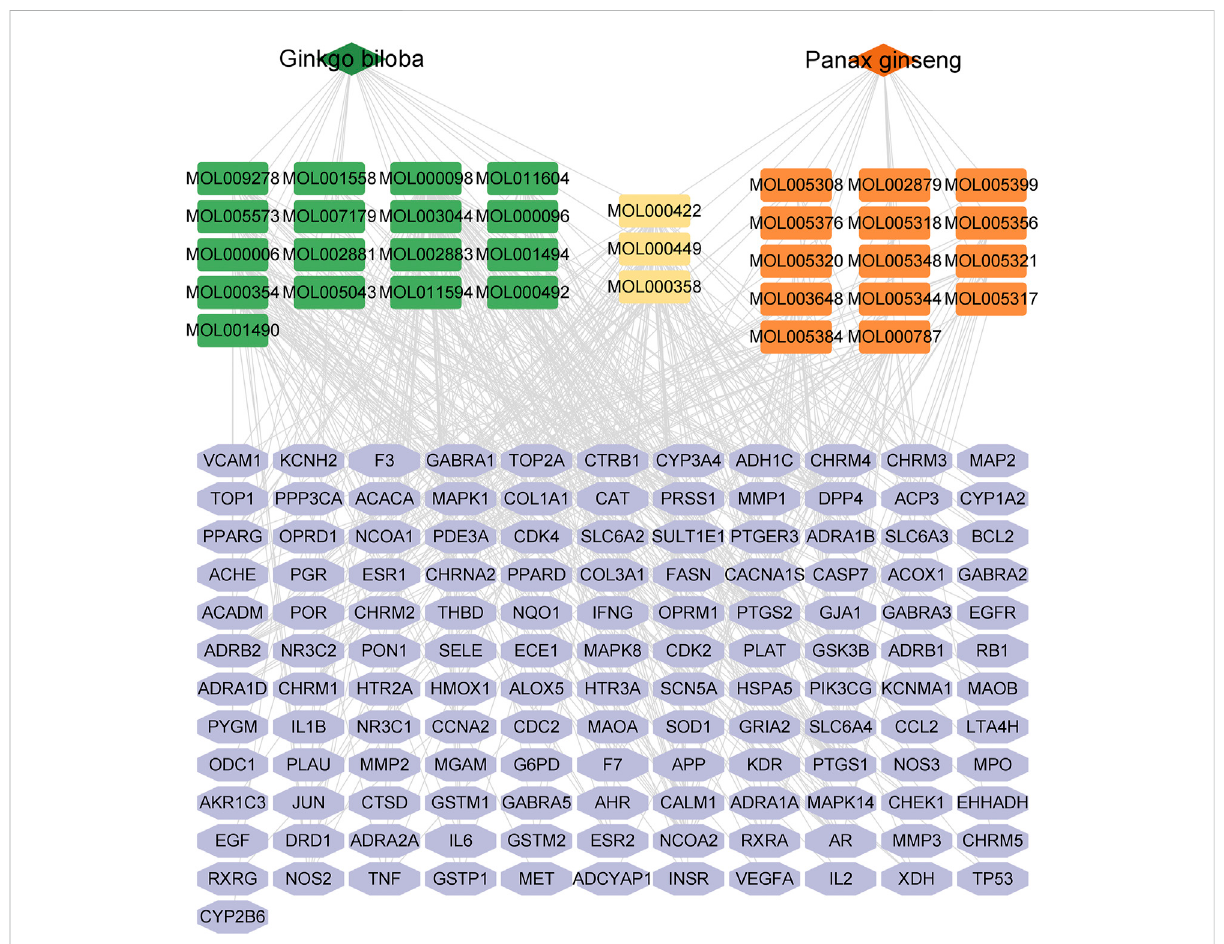
FIGURE 3 The compound-target network of CGGE.